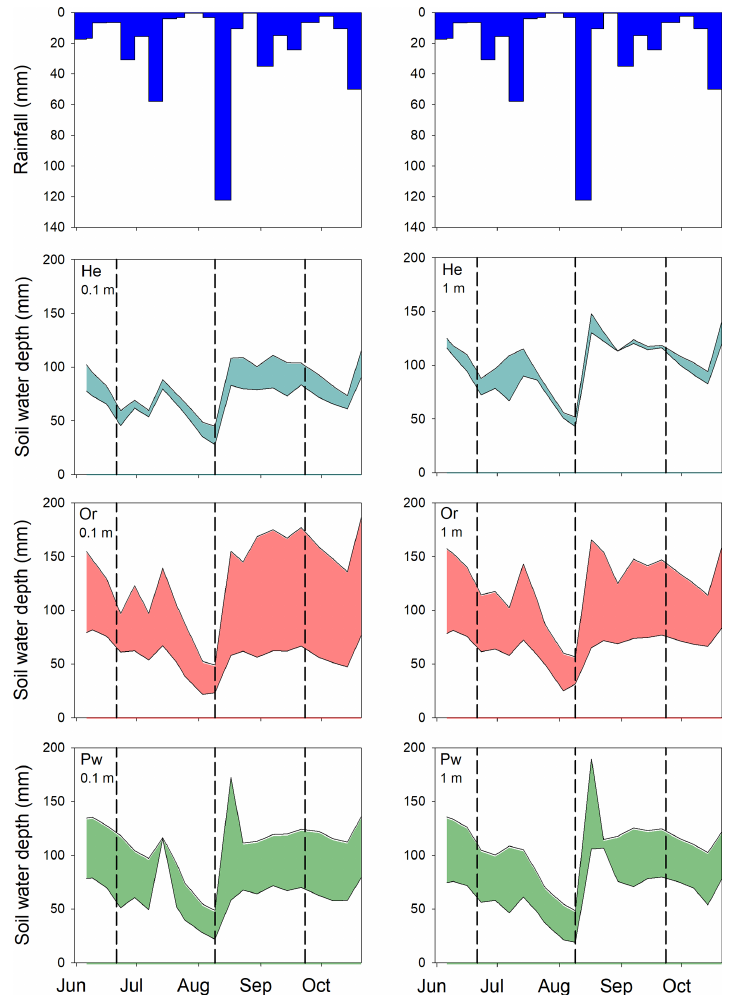
Figure A1. Rainfall depths and range of total soil water depths held in the upper 0.5m of soil at 0.1 (left-hand panels) and 1m (right-hand panels) from the bole of He (second row), Or (third row) and Pw (fourth row) trees during the 2016 growing season. Vertical dashed lines indicate the timing of post-leaf out, peak leaf out and pre-senescence sampling of xylem water and bulk soil